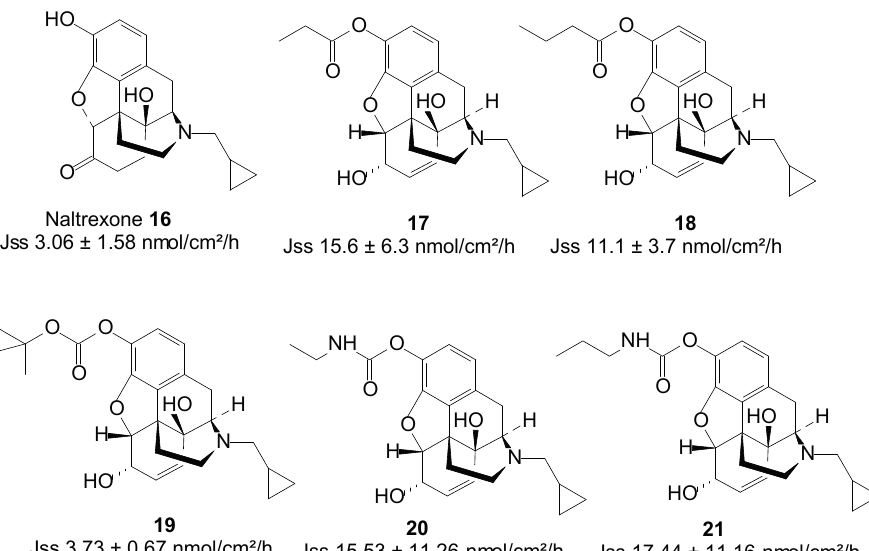
Figure 6. Naltrexone and its best skin penetrant